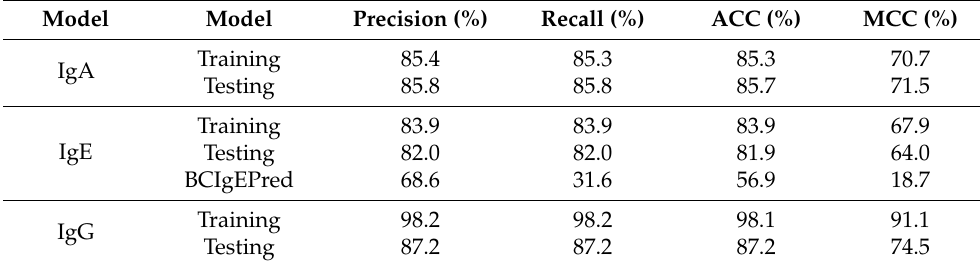
Table 4. Test results for the IgE, IgG, and IgA models.